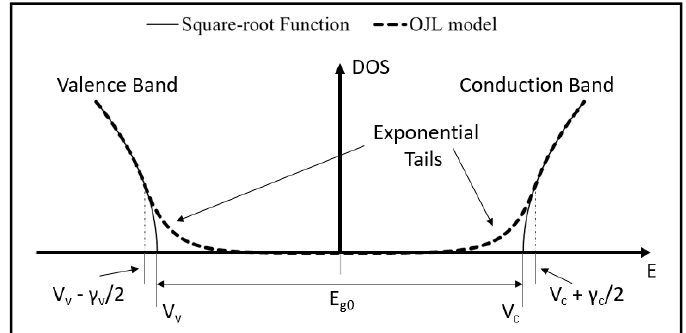
Figure 2. The diagram of energy band structure of amorphous semiconductor as described by Equations (1) and (2), thin solid curve: for crystal band structure; thick dash curve: for amorphous band structure.